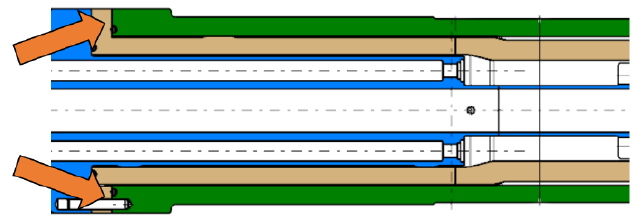
Fig. 3. Location of the optional end-weld.